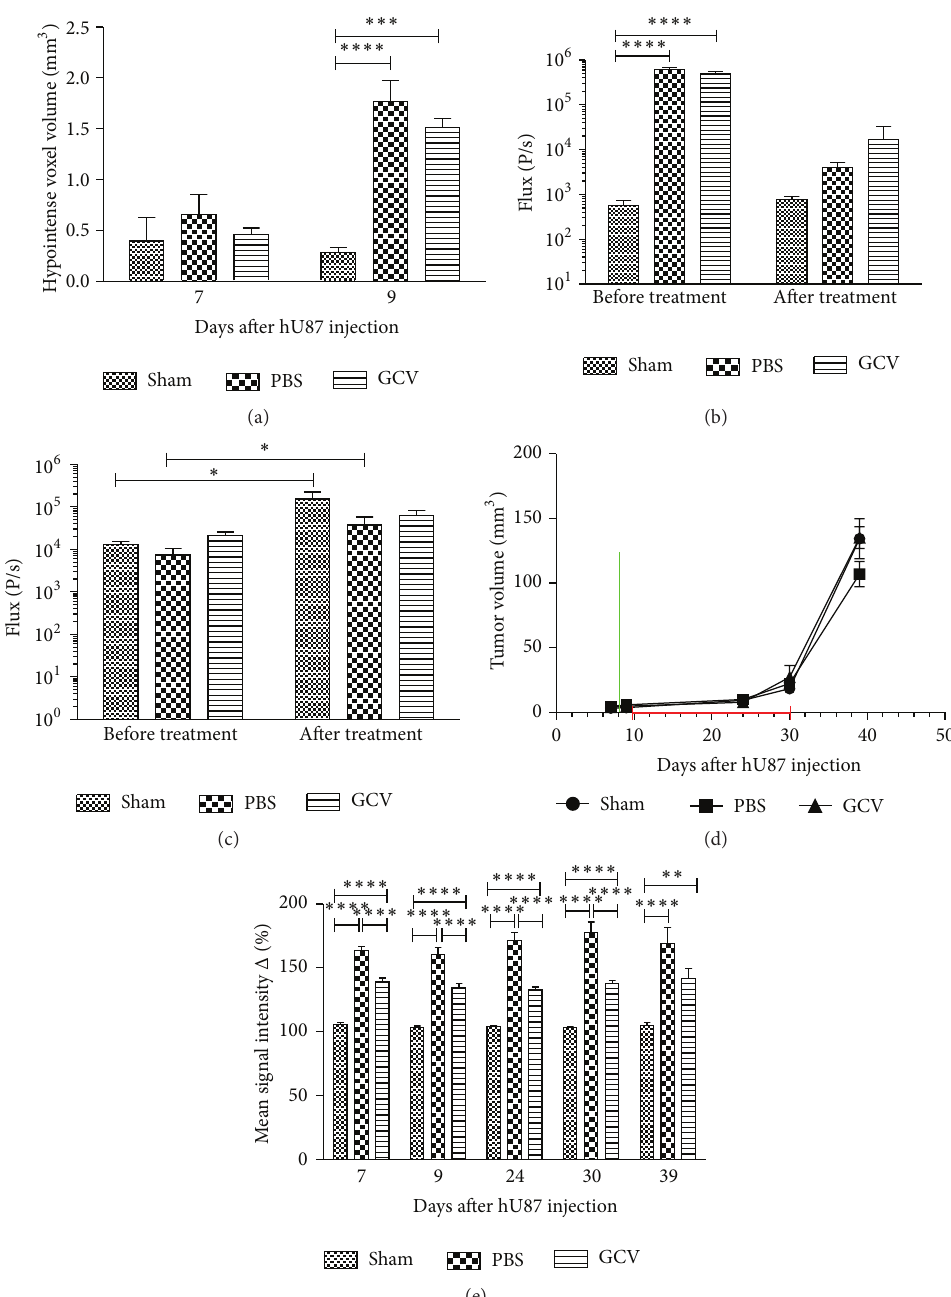
Figure 9: Quantification of in vivo imaging data to monitor suicide gene therapy using hMultistem as cellular vehicles in the